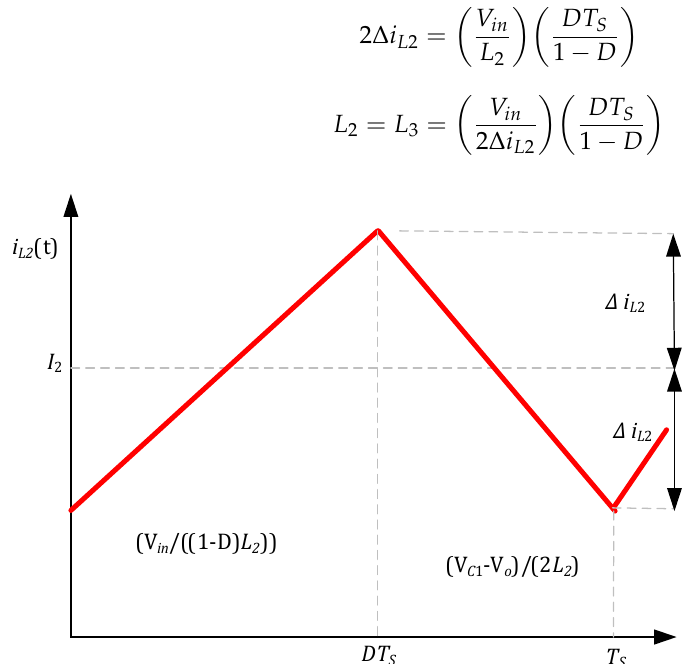
Figure 8. The inductors L 2 and L 3 currents.